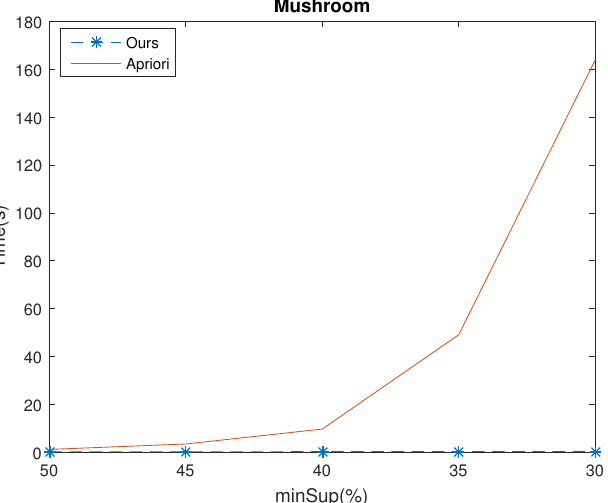
Figure 5. Execution time of the two algorithms in Connect dataset for various minSup values.